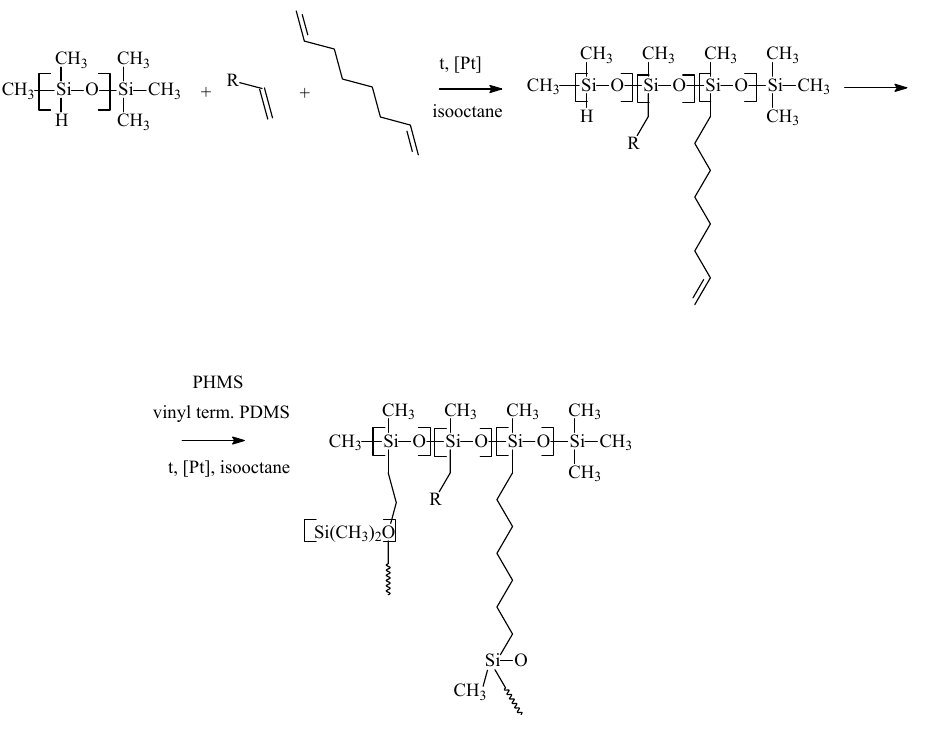
Figure 1. Scheme of the hydrosilylation reaction to produce cross-linked polyalkylmethylsiloxanes.